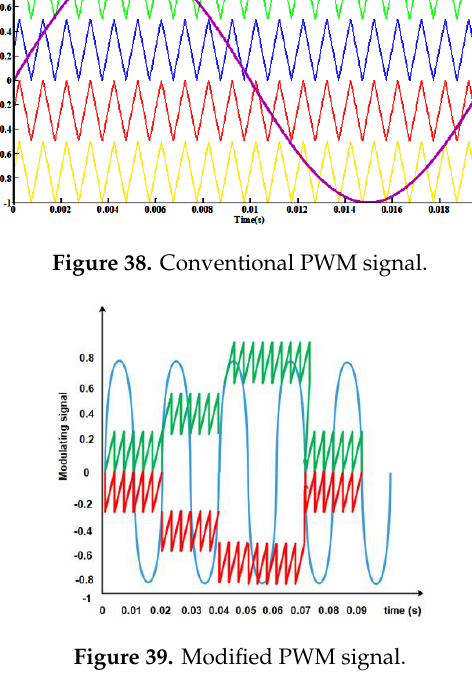
Figure 40. Waveform for hybrid PWM technique. Another hybrid modulation technique is investigated in [53]. The authors have explained a PWM technique with the hybridization of the fundamental frequency modulation (FPWM) and multiple sinusoidal modulations (MSPWM) techniques. The generated wave has reduced switching loss as in the case of FPWM and also delivers as good harmonic characteristics as that of a MSPWM method. This hybrid modulation scheme is integrated with sequential switching and simple base PWM circulation scheme in order to balance the power dissipation among the power modules.